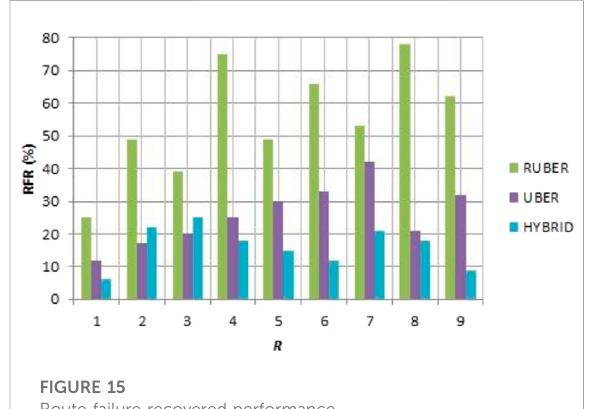
FIGURE 16 Cluster survival ratio performance.